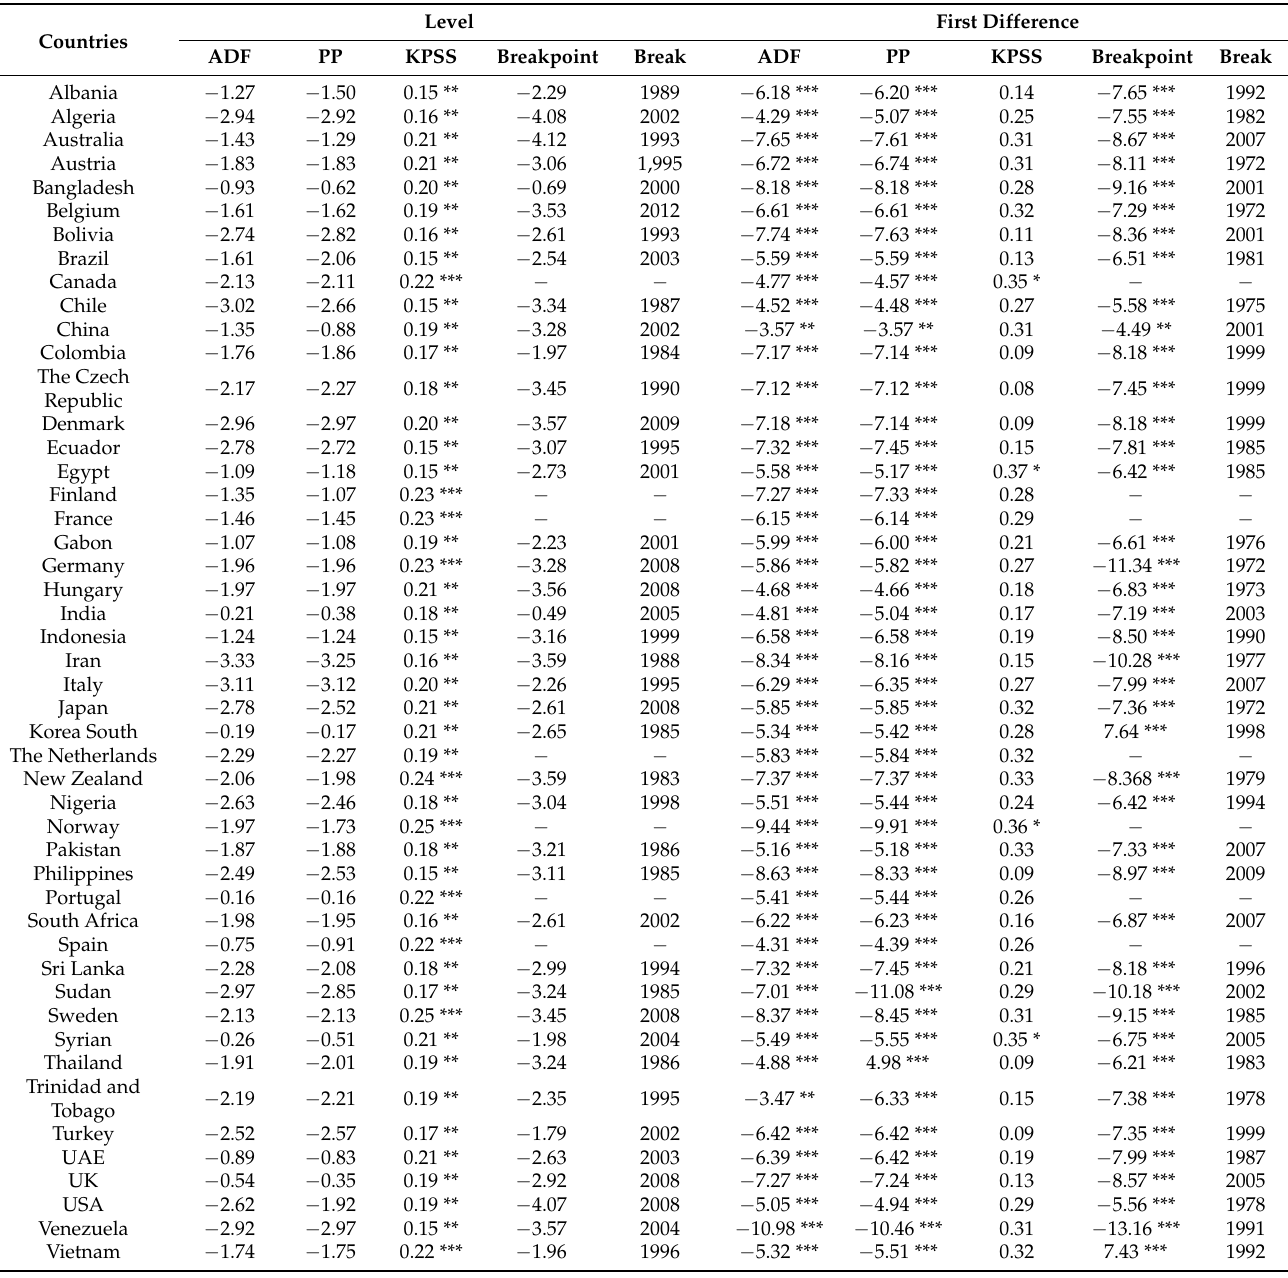
Table A2. Unit root rest—real energy consumption per